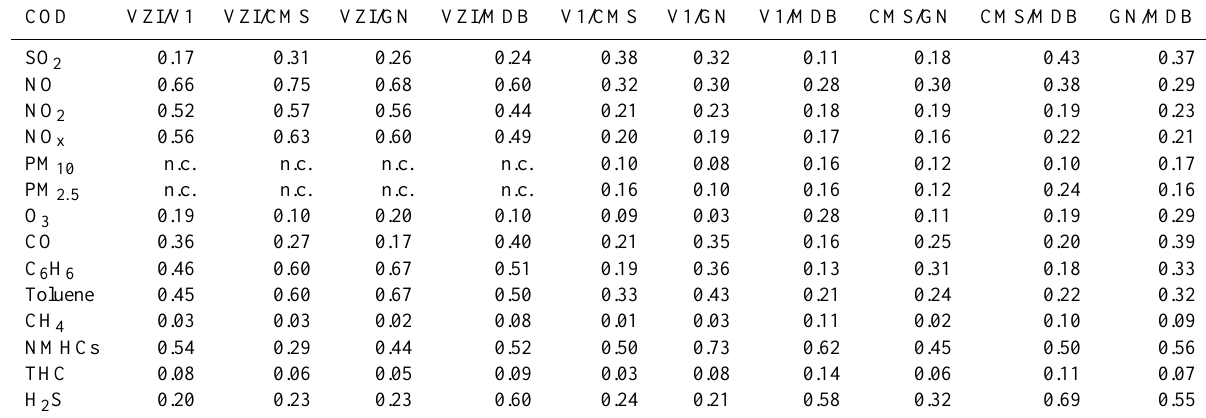
Table 4. Coefficients of divergence (CODs) calculated for each pollutant and each pair of stations. Legend: n.c. – not calculable.